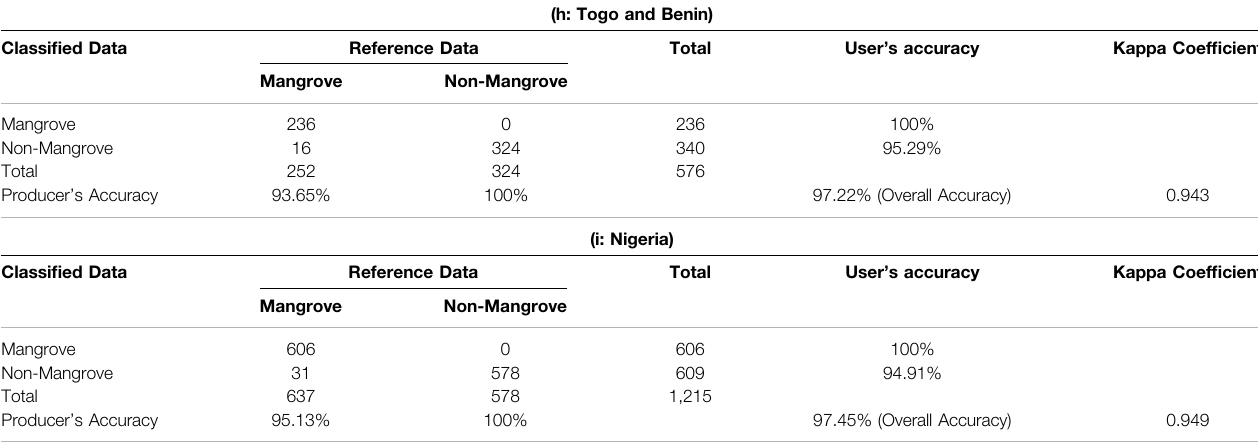
TABLE 2 | ( Continued ) Quantitative accuracy assessment for the machine learning ensemble performance and related mangrove extent data product: confusion matrix for (a) Senegal and The Gambia, (b) Guinea-Bissau, (c) Guinea, (d) Sierra Leone, (e) Liberia, (f) C ˆ ote d ’ Ivoire, (g) Ghana, (h) Togo and Benin, and (i) Nigeria. (h: Togo and